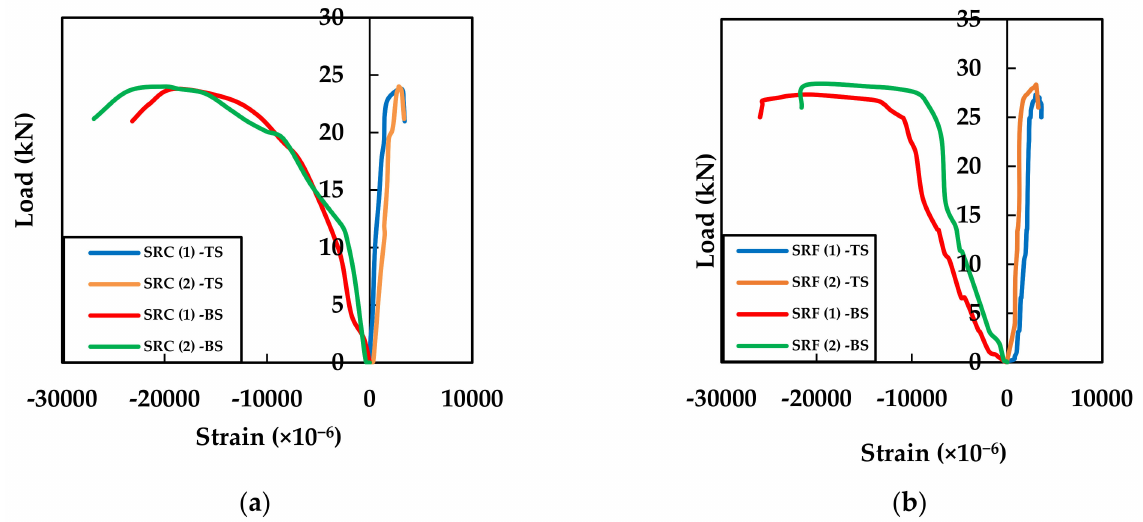
Figure 15. Load–strain behaviour of ( a ) SRC and ( b ) SRF. TS—top strain, BS—bottom strain.